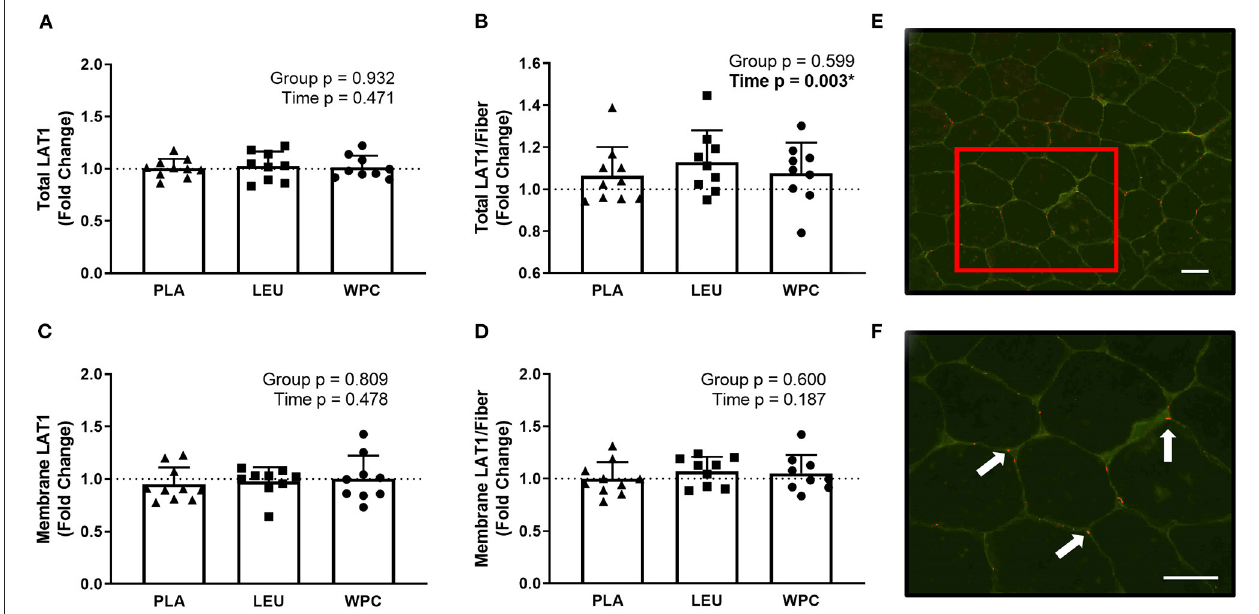
FIGURE 3 | LAT1 protein increases per skeletal muscle fiber with resistance exercise training but the increase in protein is not located on the membrane. The fold change from PRE, designated as the dashed line at 1.00, for Total LAT1 (A) , Total LAT1 per fiber (B) , Membrane LAT1 (C) , and Membrane LAT1 per fiber (D) protein content for each group using immunohistochemistry. A representative image showing green-stained dystrophin and red-stained LAT1 protein using 20x magnification (E) ; the inset in E is magnified using 40x magnification (F) and the arrows point toward LAT1 protein. The scale bar in both images is 100 µ m. *A significant effect. Data are represented as mean ± standard deviation. Sample size for each group is PLA = 10, LEU = 9, and WPC = 9.